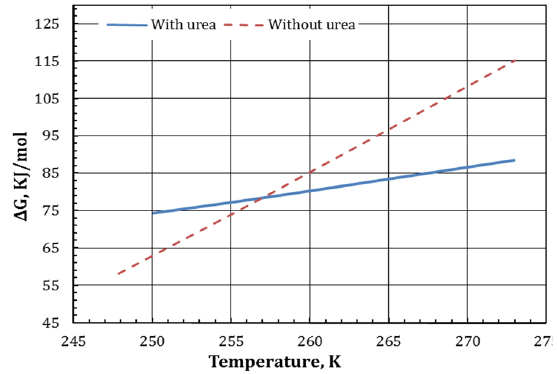
Fig. 11. Gibbs free energy for cellulose dissolution by NaOH with and without urea